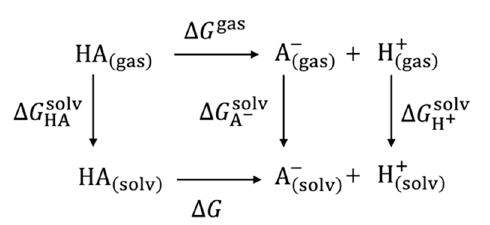
Figure 1. Schematic description of thermodynamic cycle of the acid dissociation reaction.